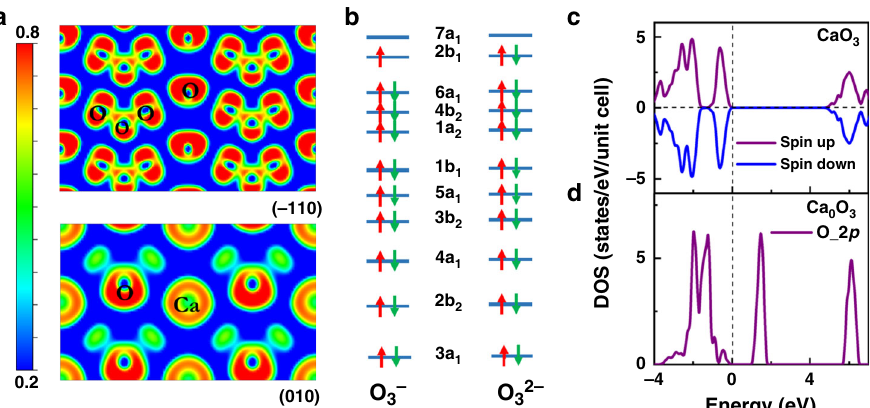
Fig. 3 Charge and magnetic order in CaO 3 . a Calculated 2D electron localization function of CaO 3 plotted in the ( − 110) and (010) planes at 30 GPa. b The molecular orbitals-scheme for O 3 1 − and O 3 2 − , following the sequence in refs. 29,49 . The red and green arrows represent spin-up and spin-down electrons, respectively. c Density of states (DOS) of CaO 3 at 30 GPa and d The O 2 p states for hypothetical Ca 0 O 3 , which exhibits partially unoccupied bonding states between 1 and 2 eV that become fi lled by electrons transferred from Ca in CaO 3 . The vertical dashed line indicates the position of the Fermi energy.